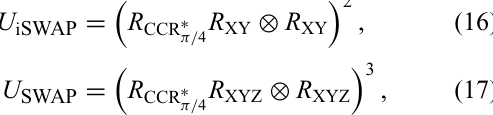
FIG. 3. (a) Gate sequence to generate i SWAP gate with two CCR gates. (b) Gate sequence to generate SWAP gate with three CCR gates. Experimental results from two-qubit interleaved ran- domized benchmarking for (c) i SWAP and (d) SWAP gates with the gate decomposition based on CR gates, supported by the IBM Quantum cloud provider, and with the gate decomposition based on CCR gates.